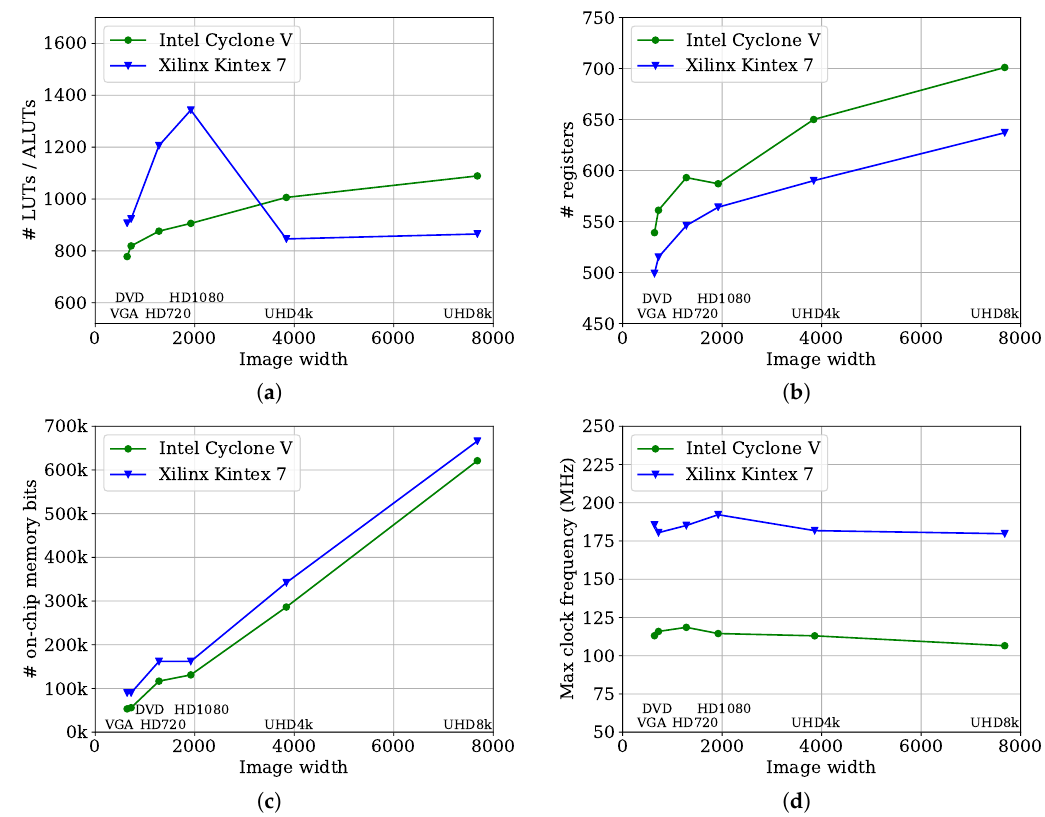
Figure 17. These diagrams that show the number of ( a ) look up tables (LUTs / ALUTs), ( b ) registers and and ( c ) on-chip memory bits for different image sizes for the implementation of the proposed CCA architecture on an Intel Cyclone V 5SEMA5F31C6 and a Xilinx Kintex 7 xc7k325-2L FPGA. In ( d ) the maximum clock frequency is